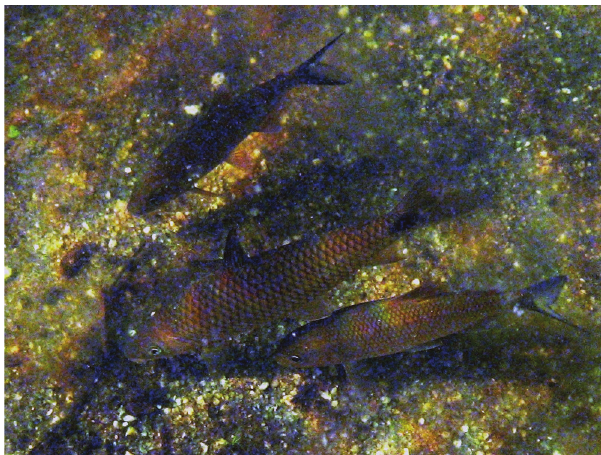
Fig. 3. Two individuals of Brycon devillei aligned sideways to the timburé, Leporinus garmani , on a sand bank in the rio Preto channel. Photo by P. G.